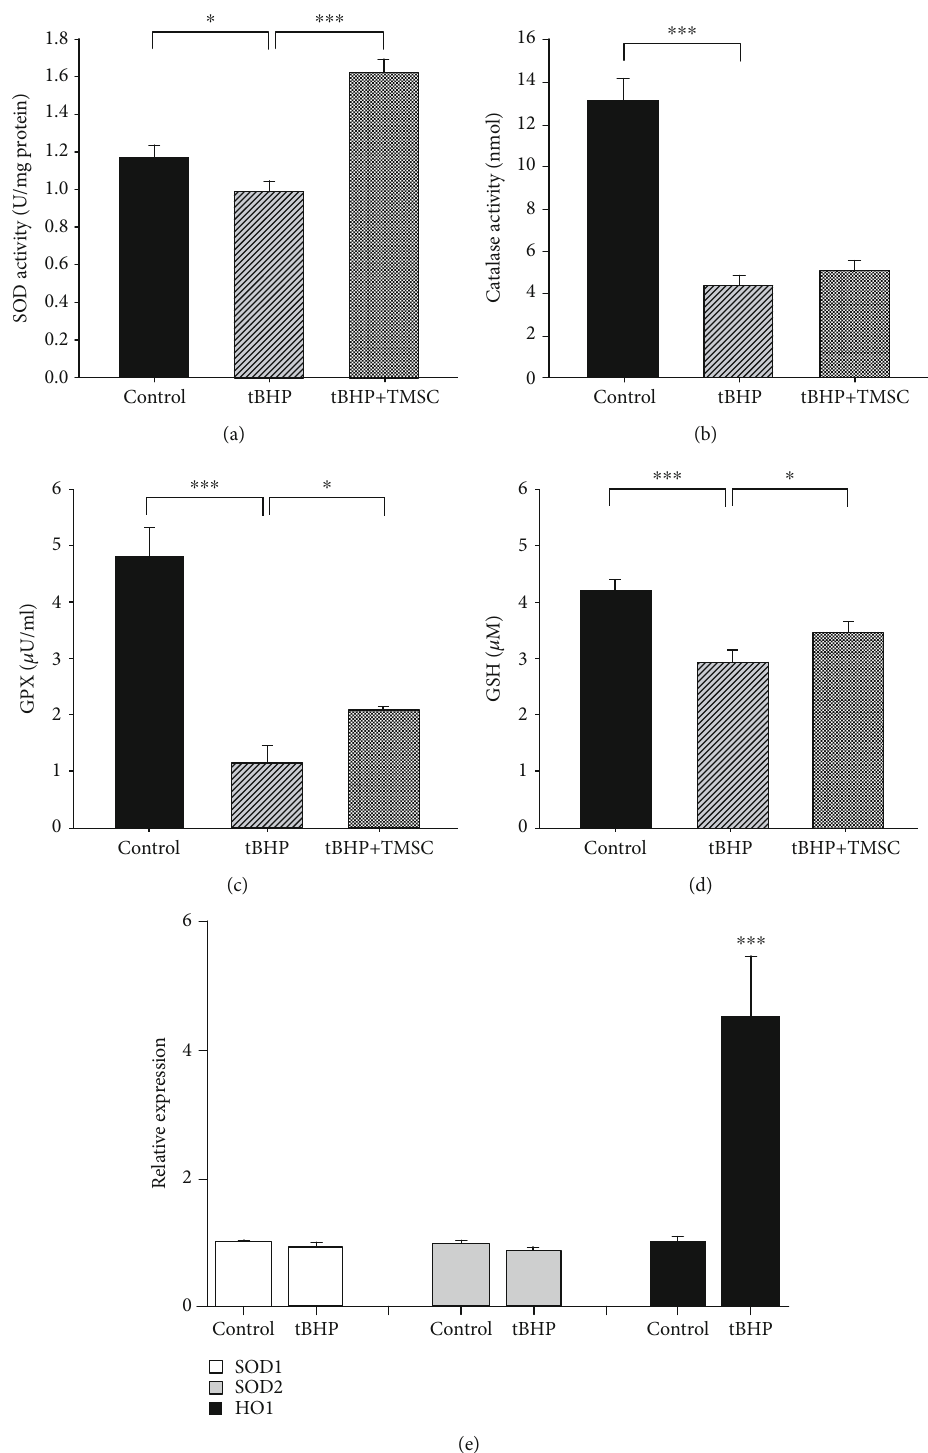
Figure 3: The dynamic changes in activity and expression of malondialdehyde (MDA) and other antioxidant enzymes. (a – d) The activity and expression of various antioxidant enzymes including superoxide dismutase (SOD), catalase, glutathione peroxidase (GPX), and glutathione (GSH) in hVFFs were signi fi cantly increased following treatment with tBHP and partially restored after coculture with TMSC. (e) qRT- PCR results showing that the HO1 mRNA level in TMSCs was upregulated upon tBHP treatment. No signi fi cant change in SOD1 and SOD2 transcript levels was observed. Results are 3 technical replicates of TMSC from one donor. Representative results from two di ff erent TMSCs with similar tendency were presented. For multigroup comparison, ANOVA followed by the Bonferroni post hoc test was used for statistics. Results are shown as the mean ± SD . ∗ P < 0 : 05 and ∗∗∗ P < 0 : 001